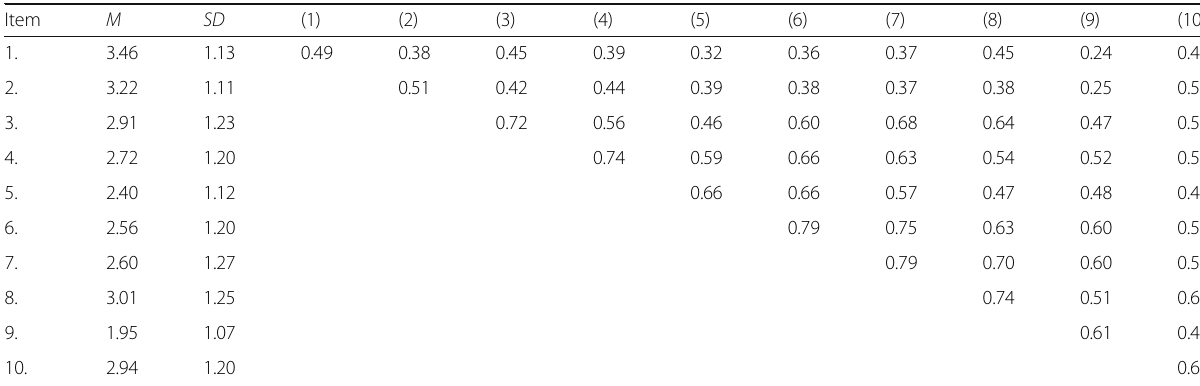
Table 4 Item-level statistics and intercorrelations of the translated P-PSE scale Item